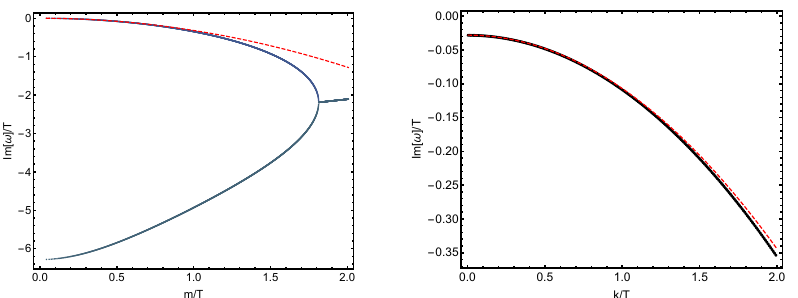
Figure 4 . Left: the imaginary part of the lowest mode of the transverse spectrum for the (cid:13)uid model (3.1) in function of the dimensionless parameter m=T . The red dashed line is formula (3.7). Around m=T (cid:24) 1 : 8 the collision indicating the coherent-incoherent transition happens. Right: the dispersion relation of the lowest mode for m=T = 0 : 2966. The dashed line is the expression obtained formula (3.7). The agreement at k=T (cid:28) 1 is